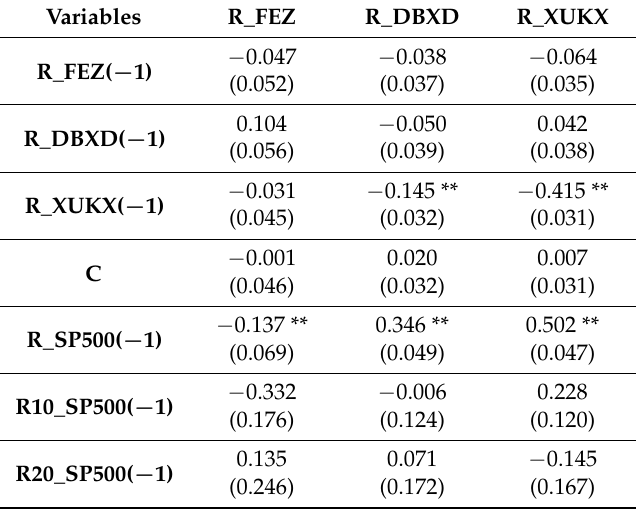
Table 5. Europe Market ETF and S&P 500